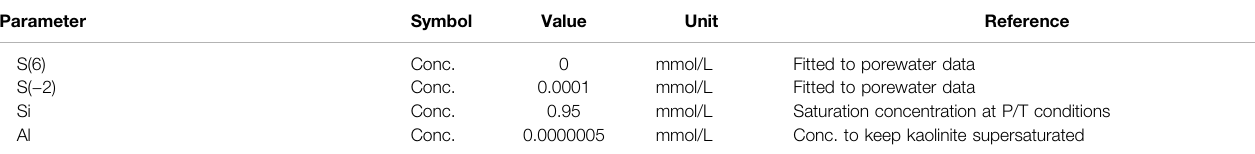
TABLE 1 | ( Continued ) List of parameters and values used for the reaction transport model.